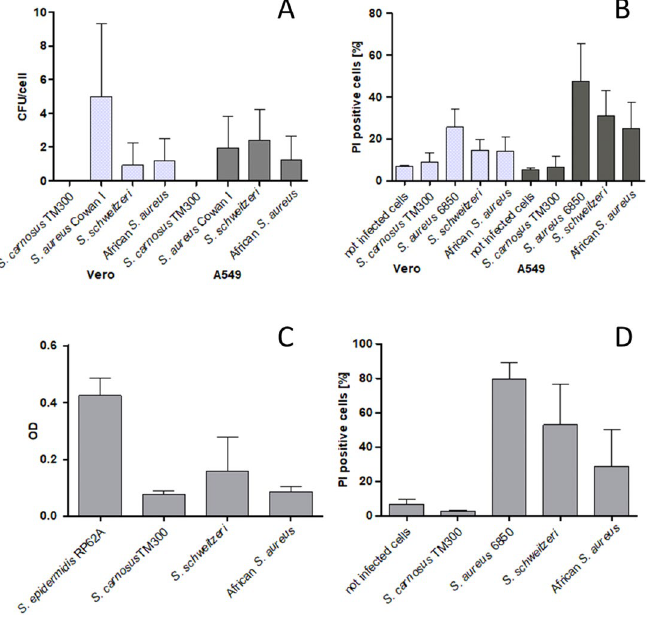
Figure 3. Comparison of the in vitro virulence of Staphylococcus schweitzeri and representative African Staphylococcus aureus . The results were merged for S. schweitzeri (n = 58) and African S. aureus (n = 6) and displayed as the mean (± SD) for each of the two groups. ( A ) Cellular invasion in Vero and A549 cells. The highly invasive strain S. aureus Cowan I served as positive and the low invasive S. carnosus strain TM300 as negative control. ( B ) Intracellular cytotoxicity after infection of Vero and A549 cells. The highly cytotoxic S. aureus strain 6850 served as positive and the S. carnosus strain TM300 as negative control. ( C ) Biofilm formation. The biofilm production was measured photometrically and bars indicated mean OD (± SD). ( D ) Extracellular cytotoxicity. A549 cells were exposed to secreted toxins in supernatants of overnight cultures. The mean cytotoxicity (proportion of dead cells, ± SD) of S. schweitzeri was significantly stronger than for African S. aureus (p =